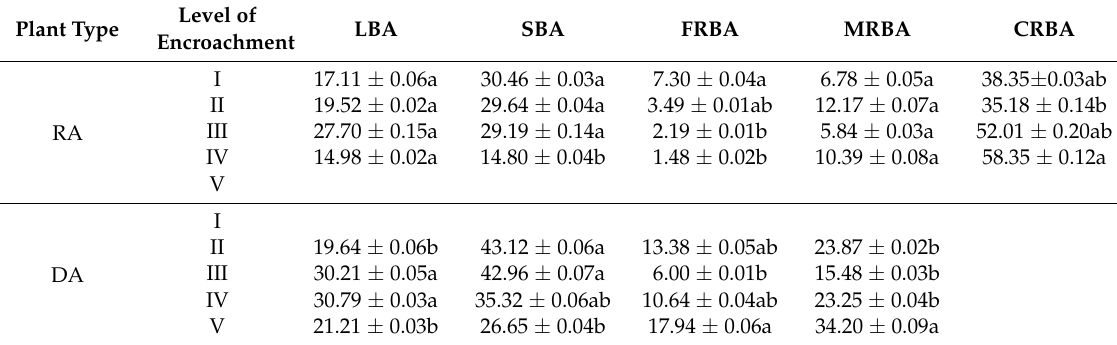
Figure 6. Root/shoot ratio of R. aureum and D. angustifolia under five encroachment levels.